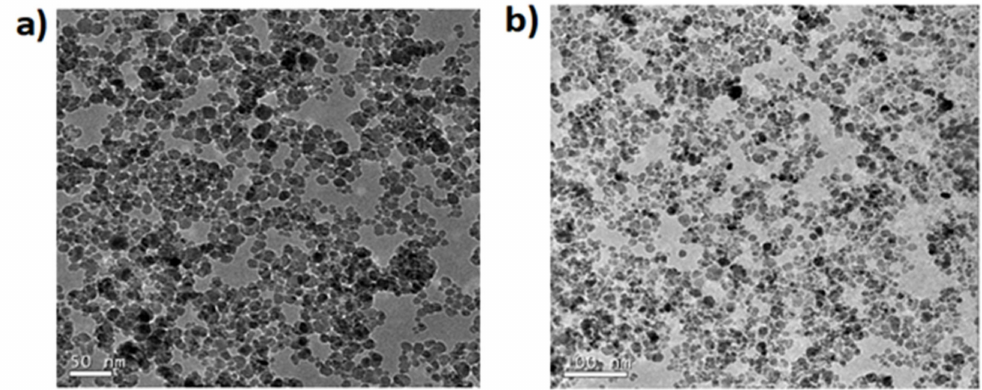
Figure 2. ( a ) Fe 3 O4@SiO 2 -NH 2 and ( b ) The Fe 3 O 4 @SiO 2 -NH 2 -COOH MNPs under TEM at 120 kV. They were measured in a copper grid. These MNPs were made by using maleic anhydride.